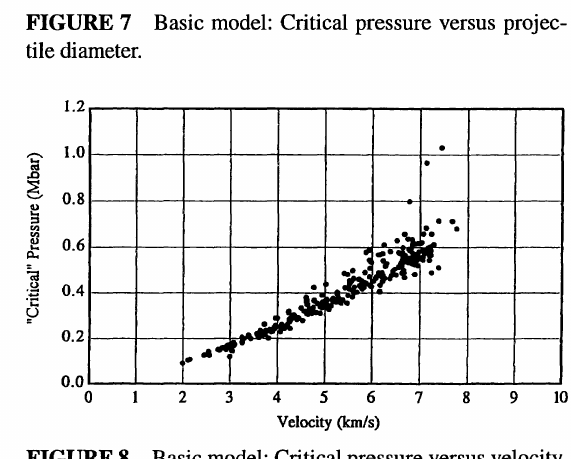
FIGURE 8 Basic model: Critical pressure versus